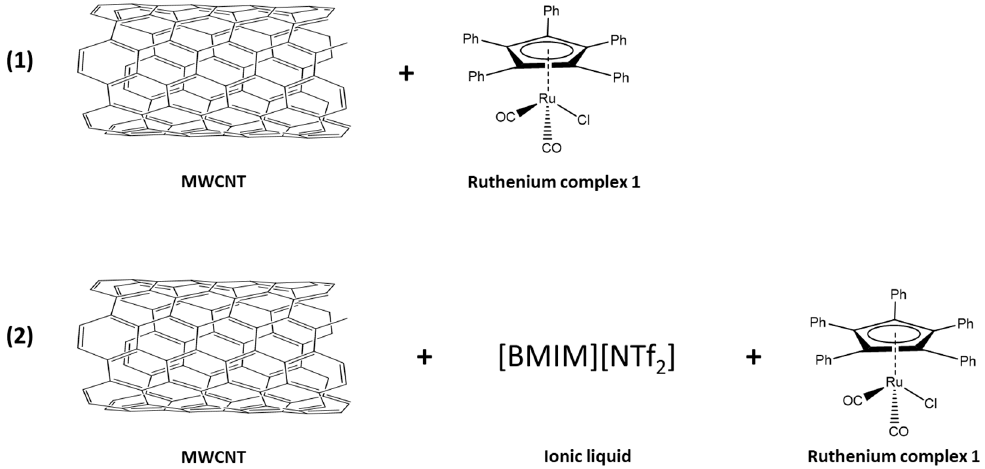
Figure 3. Two variants of non-covalent immobilization of the ruthenium complex [Ru(1)] on MWCNT; (1) [Ru(1)-MWCNT] (2) [Ru(1)-IL-MWCNT] is a SILP system.